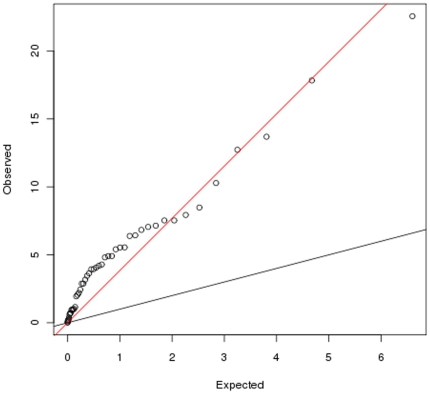
Quantile-Quantile plot of chi-square test of association p-values of 49 SNPs.